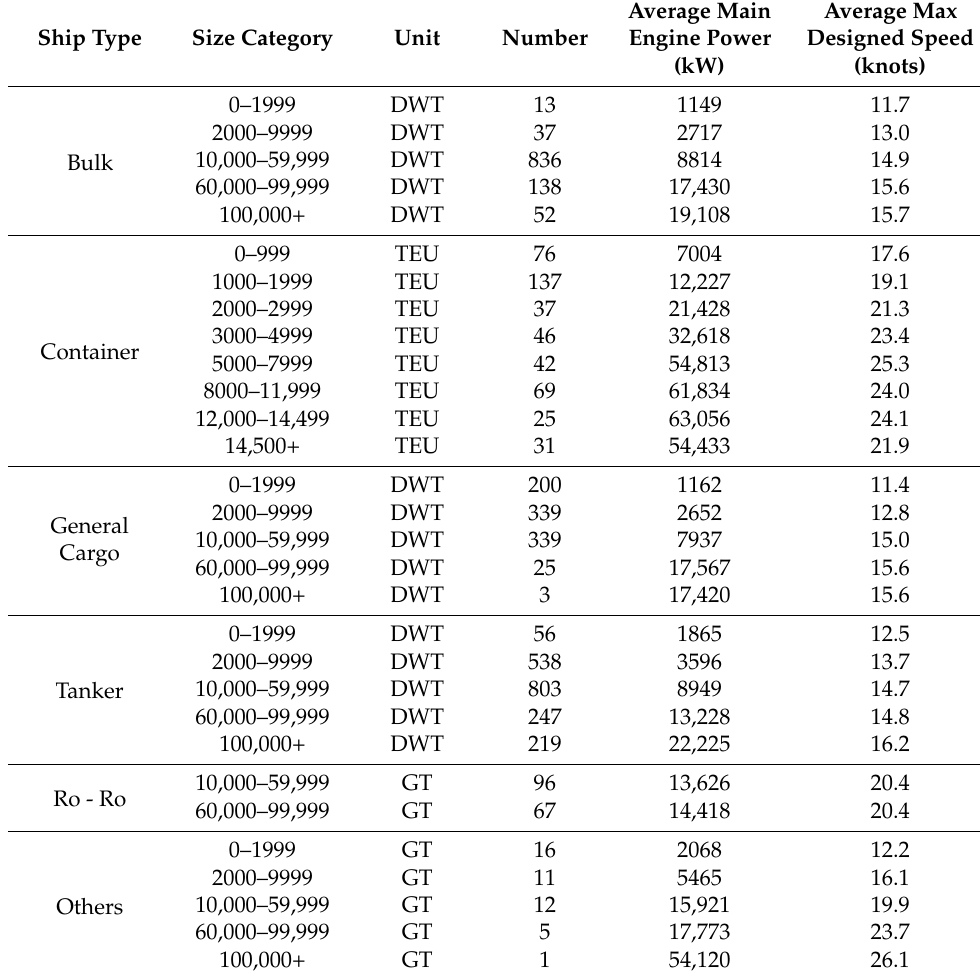
Table 3. Summary of ship specifications